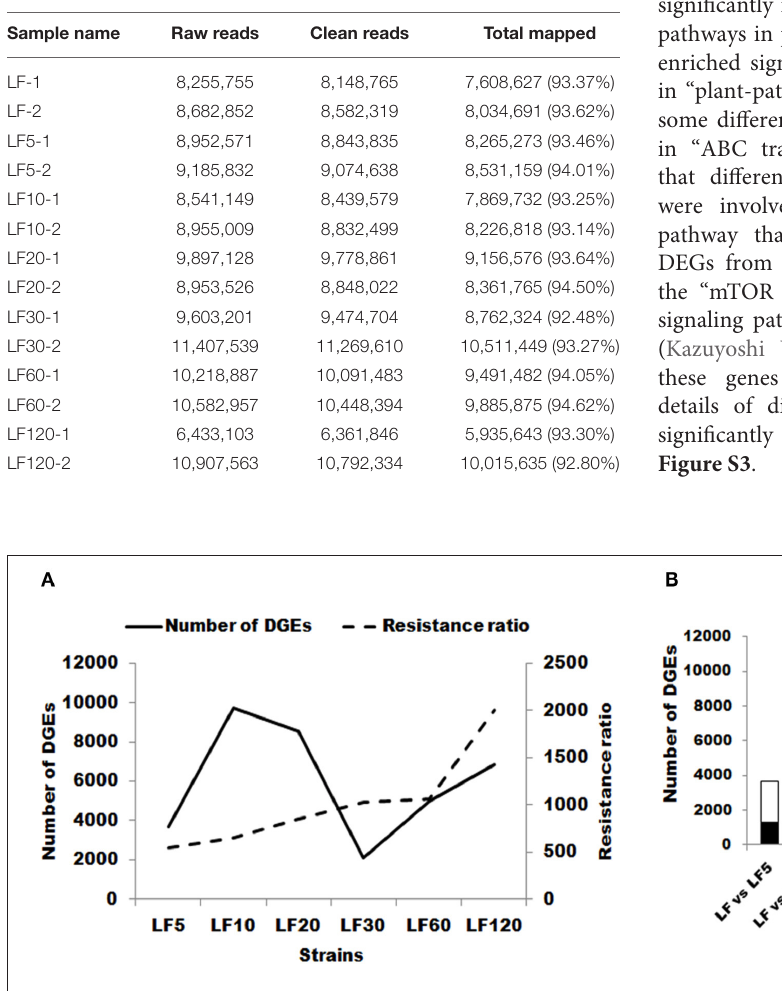
FIGURE 2 | Changes in gene expression profiles among the different resistant strains. (A) The number of upregulated and downregulated genes between LF and LF5; LF and LF10; LF and LF20; LF and LF30; LF and LF60; LF and LF120; LF10 and LF5; LF20 and LF10; LF30 and LF20; LF60 and LF30; and LF120 and LF60 are summarized. Up: upregulated in LF-resistant strains; Down: downregulated in LF-resistant strains. (B) The number of total changes in gene expression in each resistant strain and resistance ratio of each resistant strain are summarized. DEGs, differentially expressed genes.